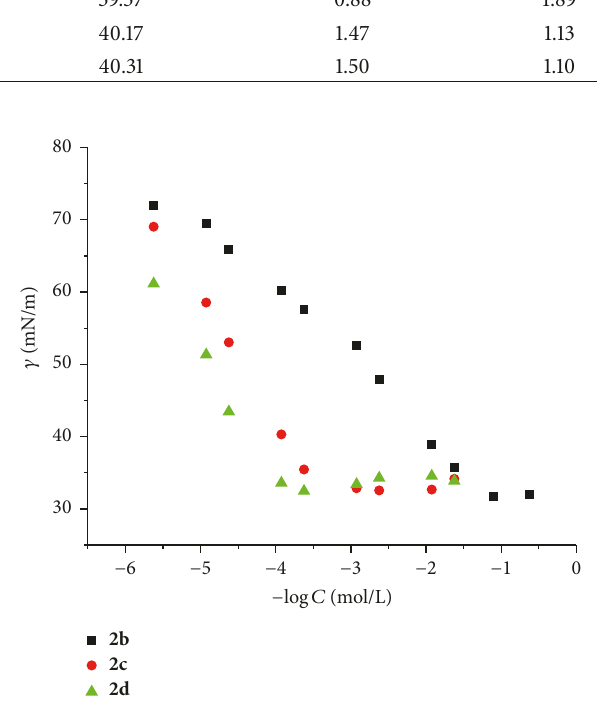
Figure 5: Surface tension at various surfactant concentrations of 2b – 2d